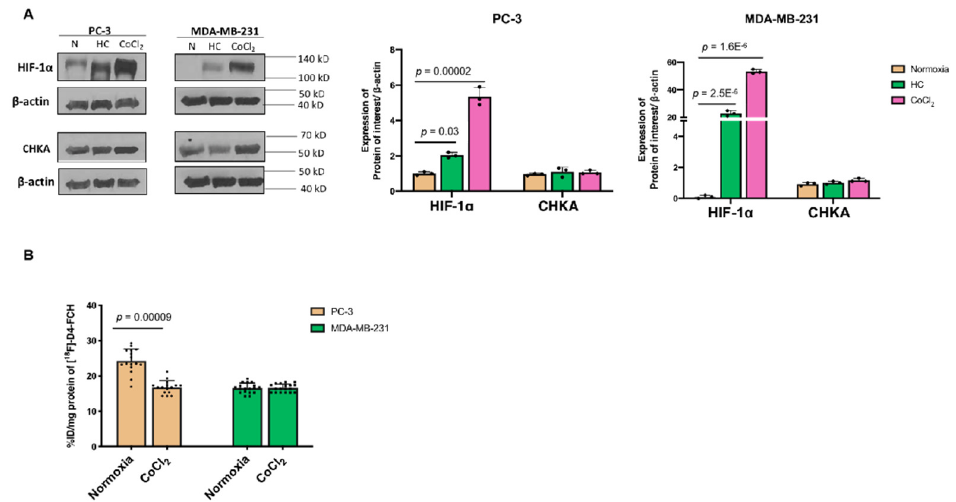
Figure 2. The effects of hypoxia or CoCl 2 treatment on the CHKA and [ 18 F]-D4-FCH uptake. ( A ) Immunoblots of the PC-3 and MDA-MB-231 cells under hypoxia (HC; <1% oxygen for 24 h) and CoCl 2 (200 µM for 24 h). ( B ) One-hour cell uptake of [ 18 F]-D4-FCH after the CoCl 2 treatment.